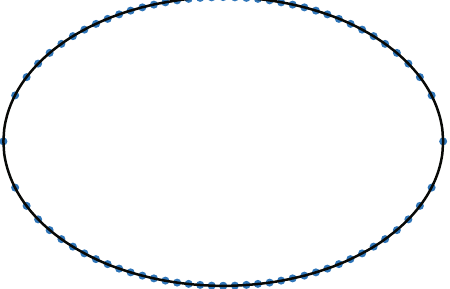
Figure 4: Numerical description of a